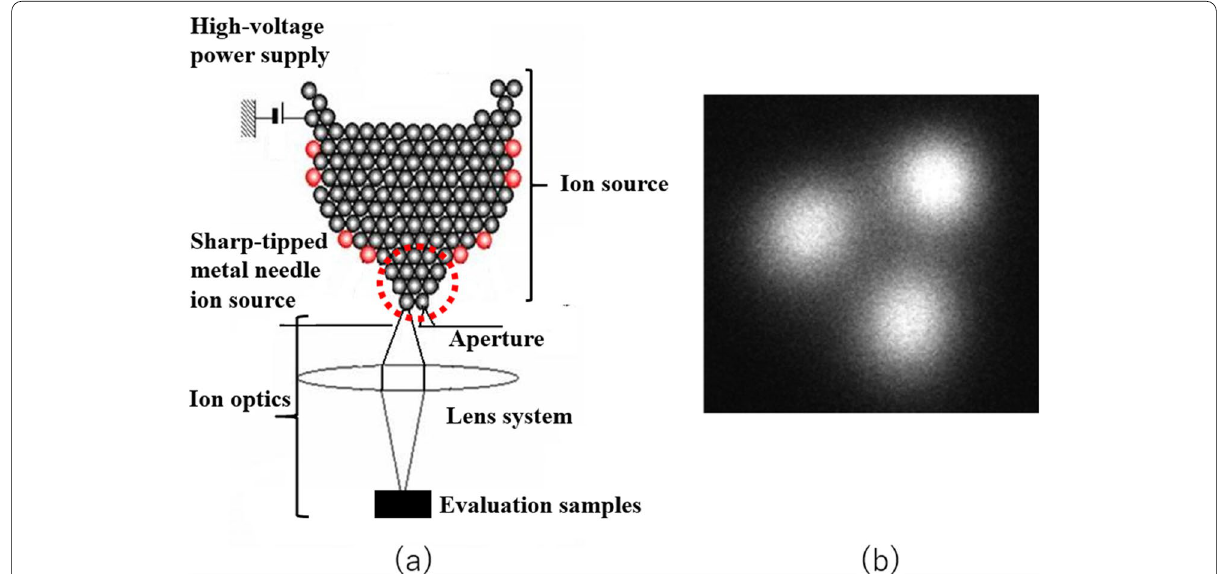
Fig. 1 a A diagram of a HIM gas ion source and ion optics and b an image of a helium ion trimer generated by ionization at the tip of the source. One of the three helium ion beams (trimer) drawn from the three atoms at the front edge is selected as the beam for sample irradiation using an aperture and accelerated at 10–35 kV. Figure modified from [6,